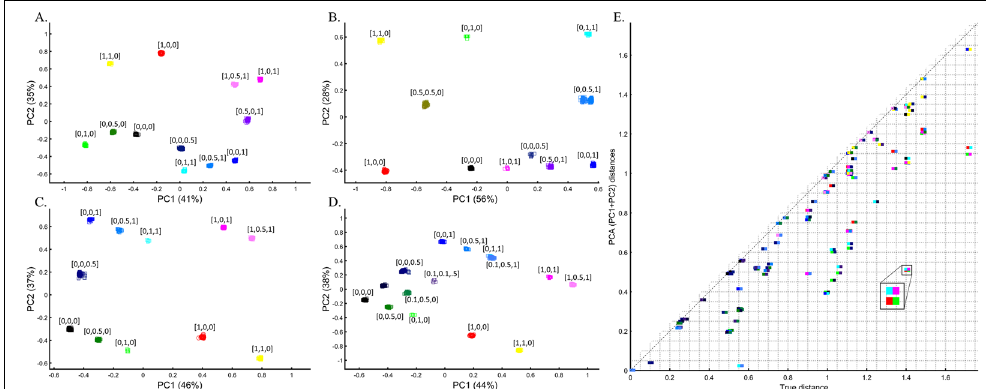
Figure 10. PCA with the primary and multiple mixed color populations. ( A ) n all = 50, ( B ) n all = 50 or 10, ( C , D ) n All = [50, 5, 100, or 25]. Scatter plots show the top two PCs. Colors codes are shown. ( E ) The difference between the true distances calculated over a 3D plane between every color population pair (shown side by side) from ( D ) and their Euclidean distances calculated from the top two PCs. Pairs whose PC distances from each other reflect their true 3D distances are shown along the x = y dotted line. One of the largest PCA distortions is the distances between the Red and Green populations (inset). The true Red-Green distance is 1.41 (x-axis), but the PCA distance is 0.5